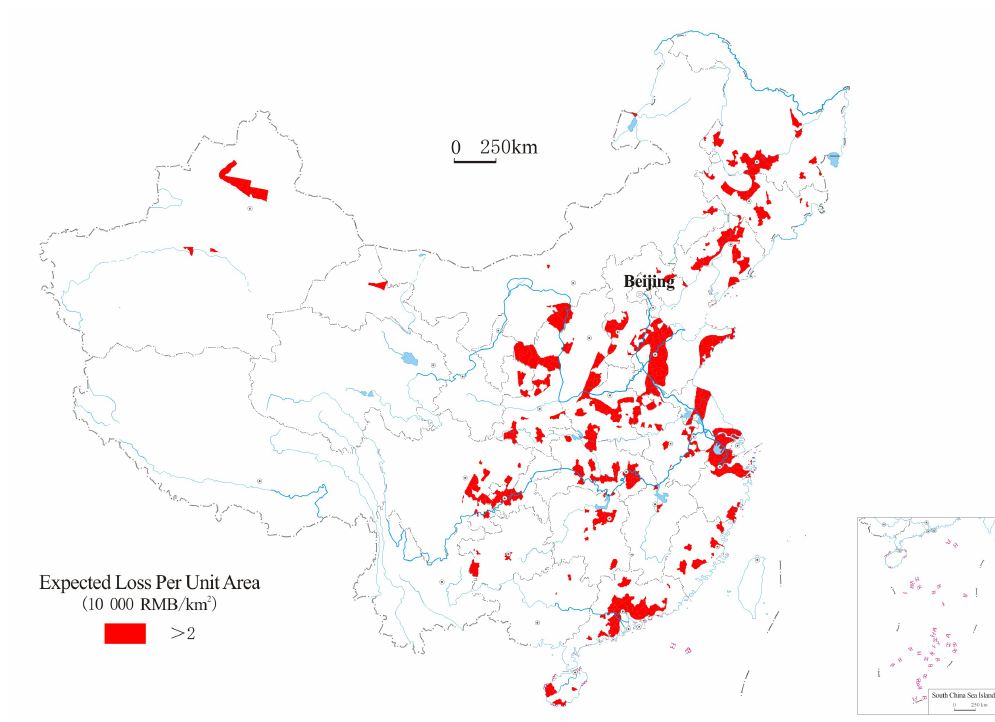
Fig. 5. Expected loss per unit area above RMB20000 in seismic PGA < 0.05 area.